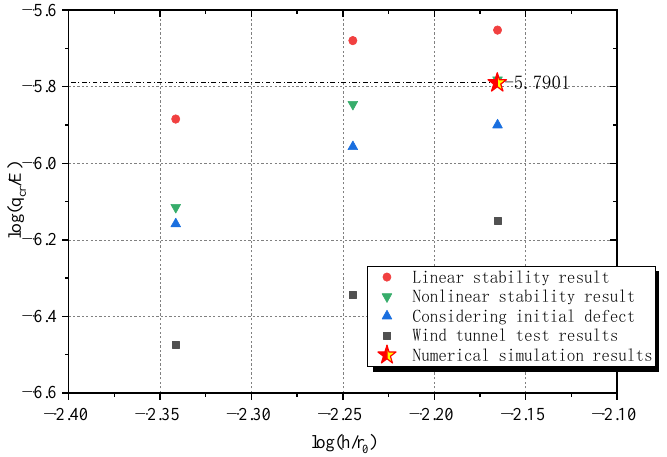
Figure 14. Comparison of stability analysis results.